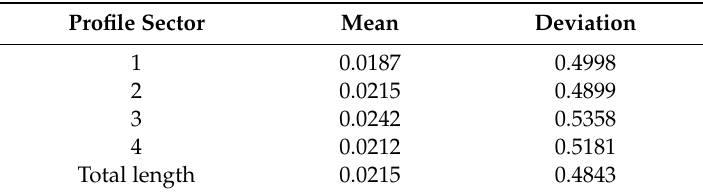
Table 2. Correlation coe ffi cients comparison.